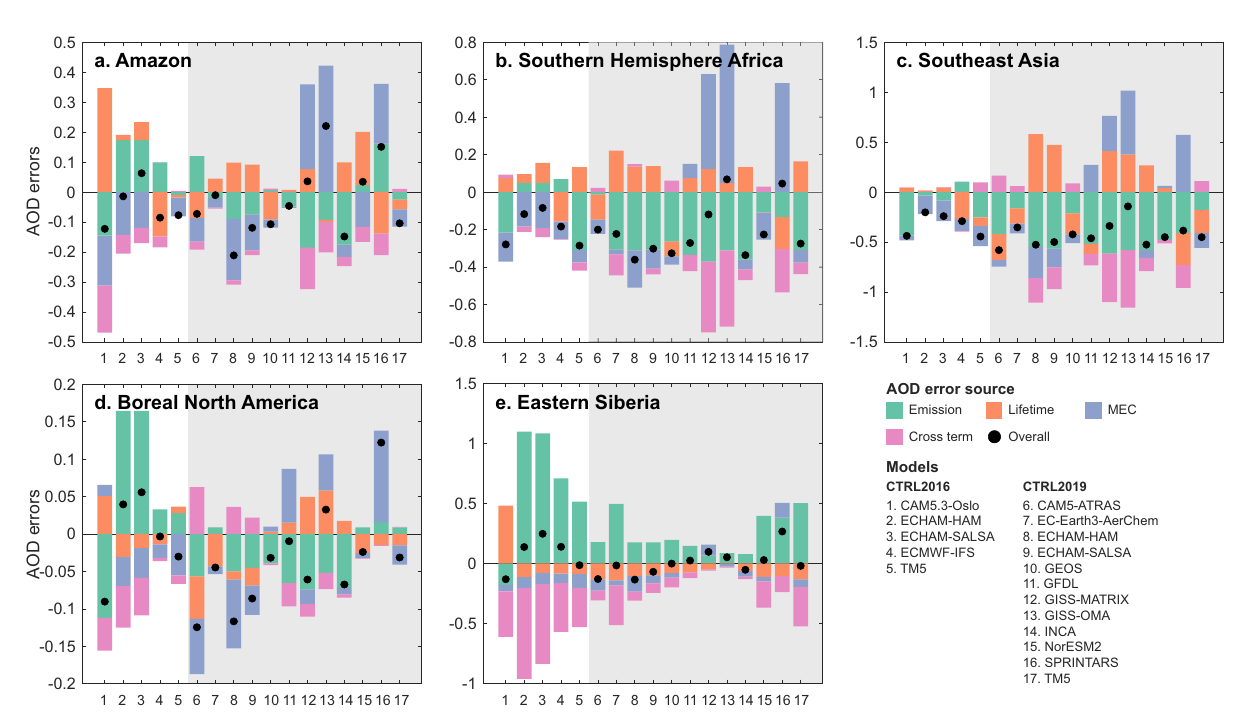
Fig. 4 | Aerosol optical depth (AOD) error attribution for AeroCom models. Total mean AOD errors during the BB seasons (black dots) are attributed to the errors intotal emission, lifetime, and MEC over the fi ve BBregion. Thecrossterms